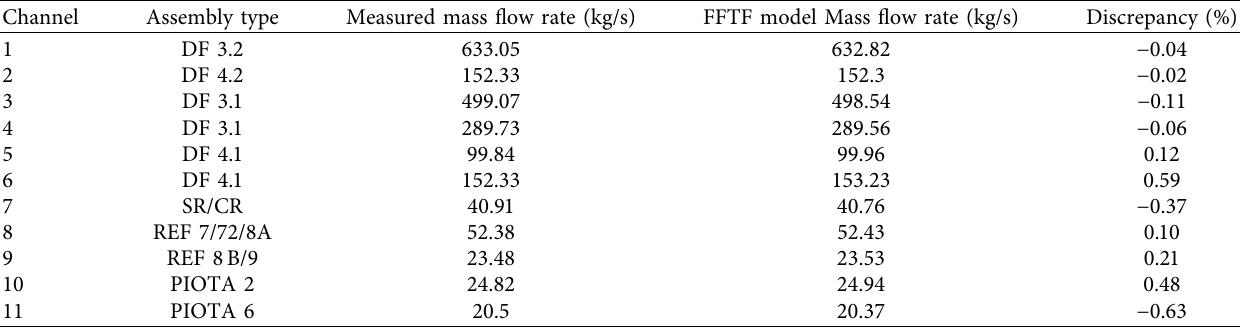
Table 3: Initial core flow distribution comparison.